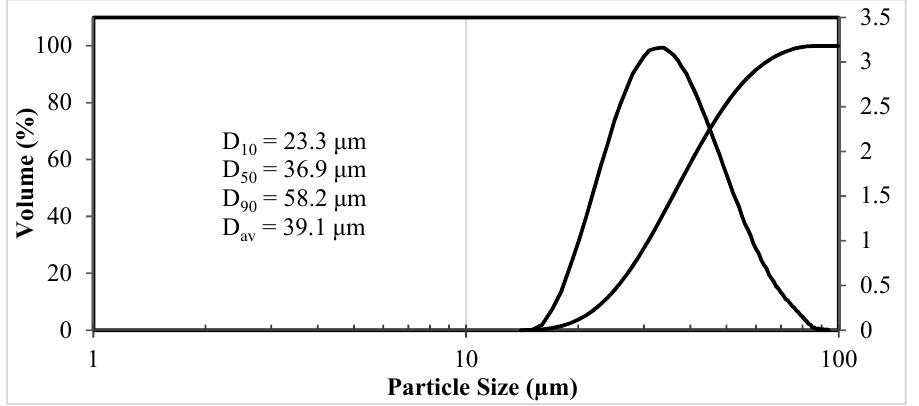
Figure 5. Differential and integral microgranules size.